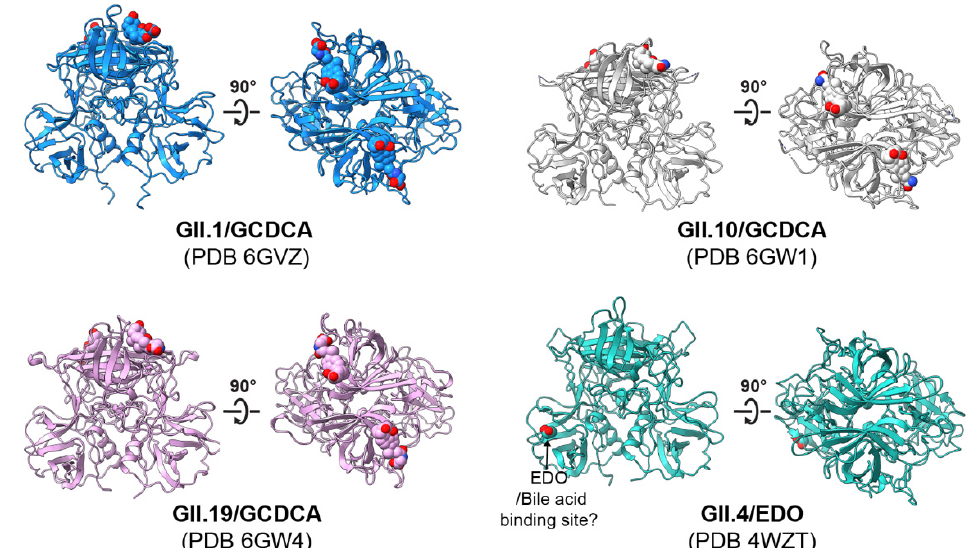
Figure 3. Bile-acid binding sites located on P domain dimers of GII HuNoVs. The P domains and bile acid are shown in ribbon representation and as spheres, respectively. The binding site of bile acid GCDCA on P domain dimers was reported by Kilic et al. [85]. An ethylene glycol (EDO, sphere representation) molecule binds to a GII.4 P domain at the bile acid binding site proposed by Creutznacher et al. [84]. GCDCA/EDO carbon coloration matches the ribbon diagram; heteroatoms are colored by element: oxygen, red; nitrogen, blue.